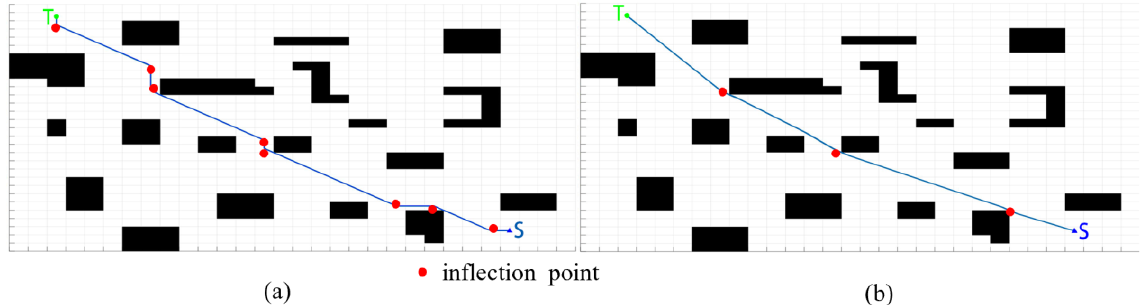
Figure 8. Algorithm simulation results: ( a ) traditional A* ( b ) improved A*.